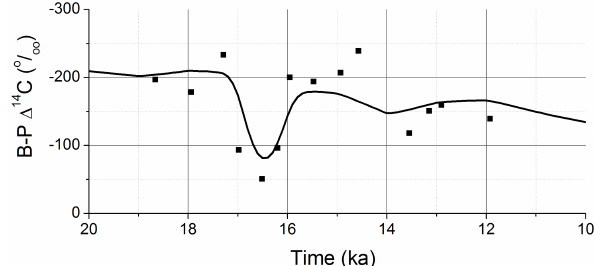
Figure A2. Deglacial benthic – pelagic radiocarbon record in the North Pacific: model (line) vs. data (squares). The (cid:49) 14 C-DIC dif- ference between deep water and surface water boxes in the North Pacific is compared to data ( (cid:49) 14 C difference between benthic and pelagic foraminifera, B-P (cid:49) 14 C) from core MD02-2489 taken at the Alaskan Margin at 3.6km water depth (Rae et al., 2014). The vertical mixing across 100 and 2000m water depth was enhanced by a factor of 10 at 16.5ka (Fig. 4d) to reproduce the radiocarbon